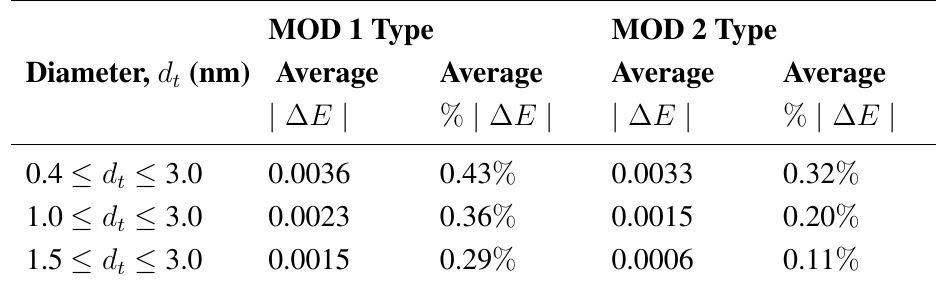
Table 1. Comparison of experimental and empirical data of E error and % average